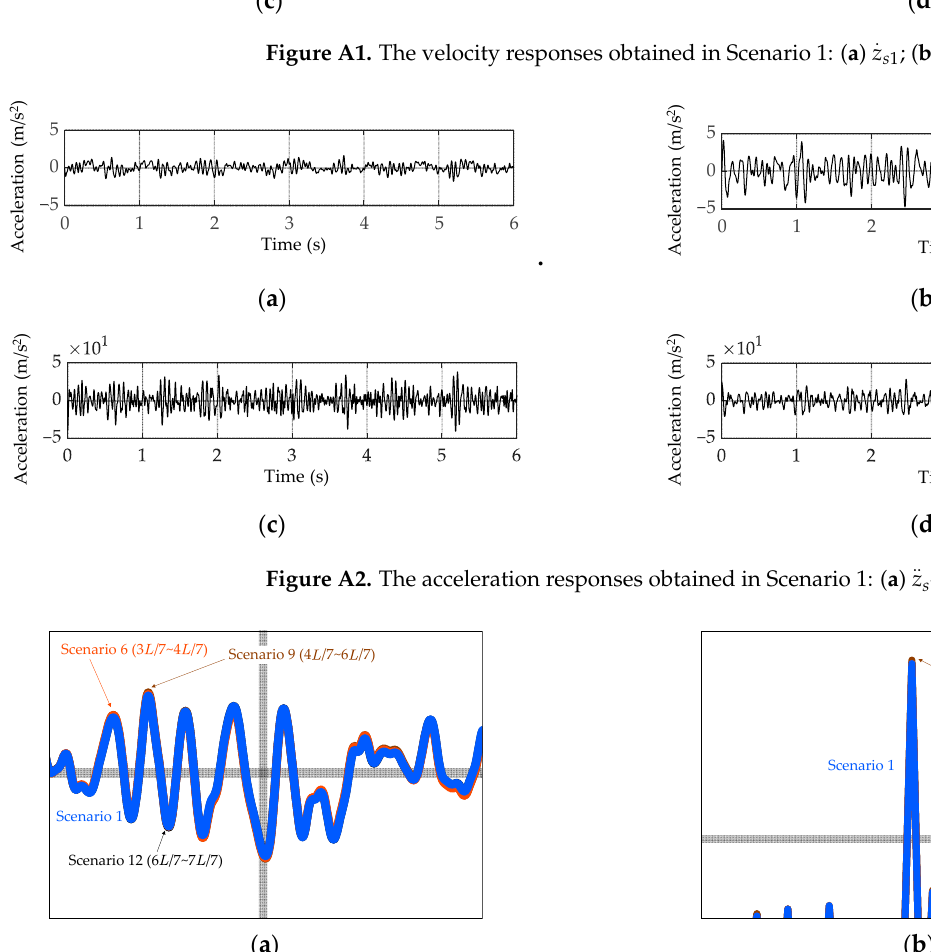
Figure A3. Enlarged view of Figure 6a 𝑧(cid:4663) (cid:3046)(cid:2869) (𝑡) and Figure 7c showing the power spectrum of 𝑧(cid:4663) (cid:3048)(cid:2869) : ( a ) Figure 6 ; ( b ) Figure 7. The differences in the vehicle responses between different scenarios are tiny because the influence of fixed road profiles is predominant.